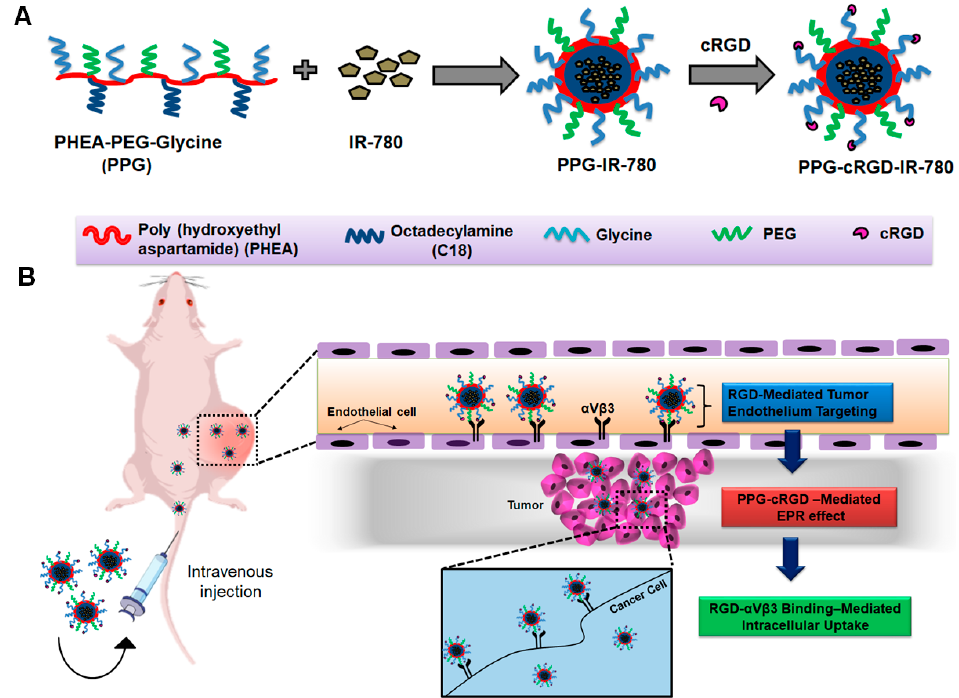
Figure 1. Schematic illustration of long-term tumor targeting and bioimaging mediated by PPG-cRGD NPs. ( A ) Synthesis scheme of PPG-cRGD NPs. ( B ) Tumor homing of intravenously injected PPG-cRGD NPs through RGD-mediated binding to tumor endothelial cells. Intratumorally accumulated PPG-cRGD NPs elicit enhanced intracellular uptake due to specific binding of PPG-cRGD NPs on α v β 3 integrin receptor in tumor cells, resulting in long-term tumor targeting and bioimaging.